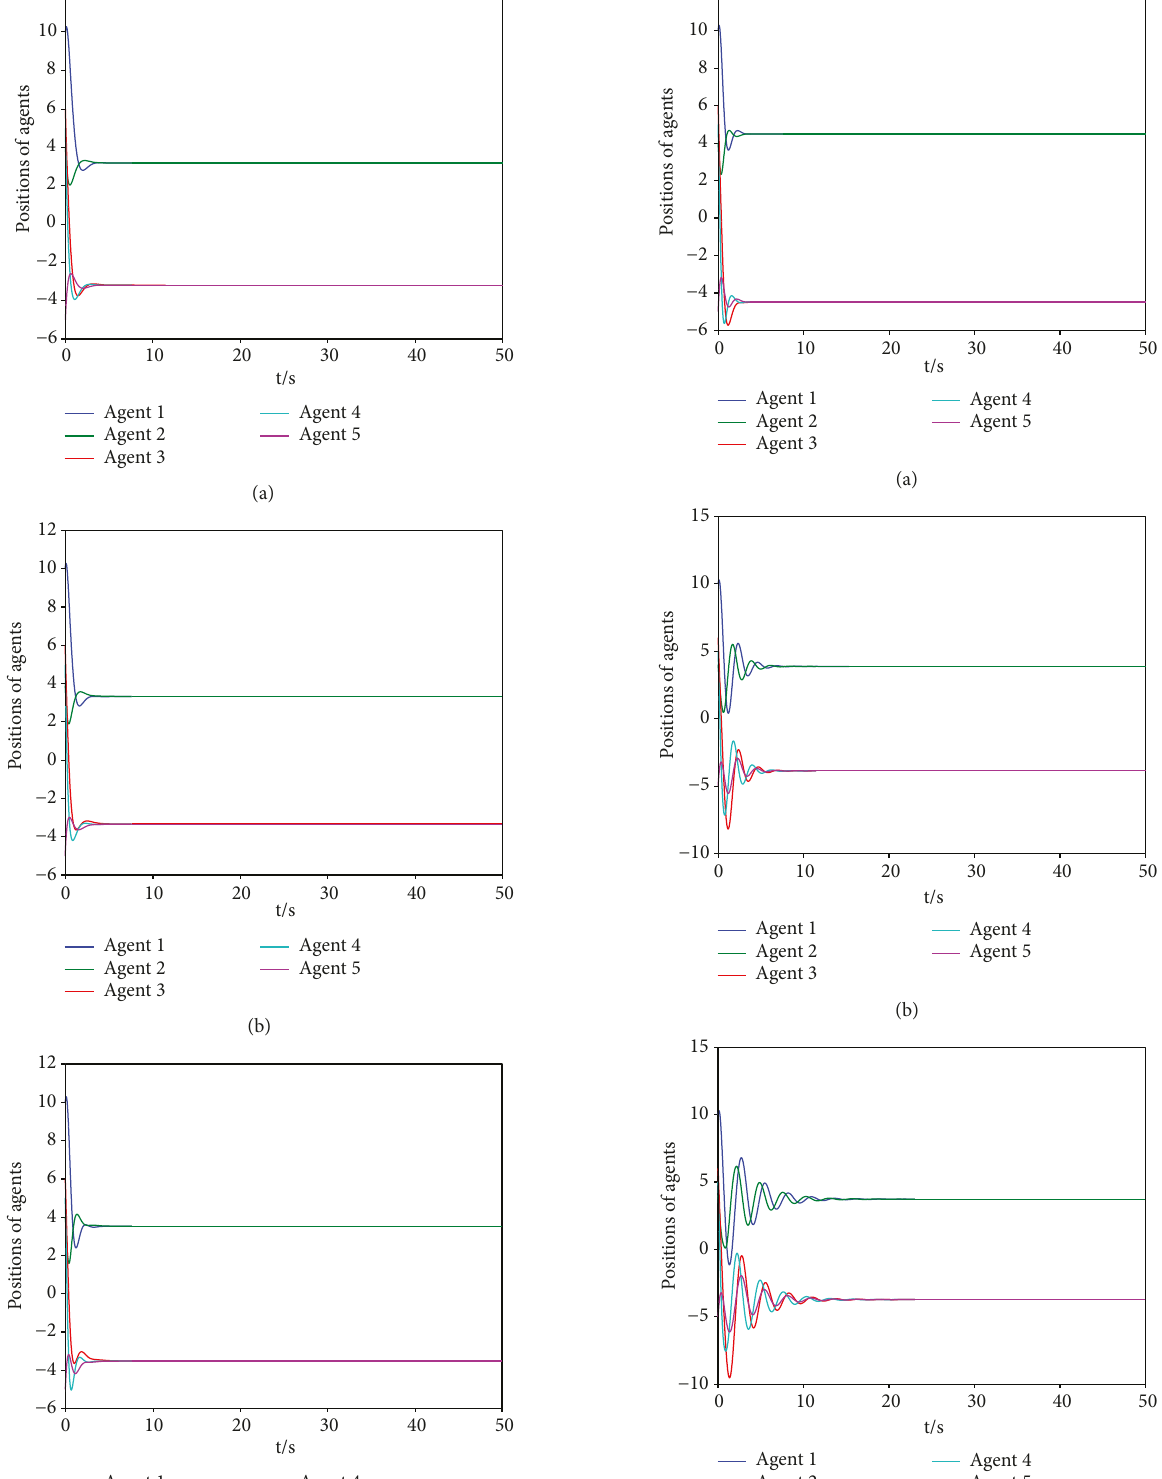
= 0 15 , τ = 0 2 , 1 2 = 0 , (b) τ = 0 5 , and (c) ij ij